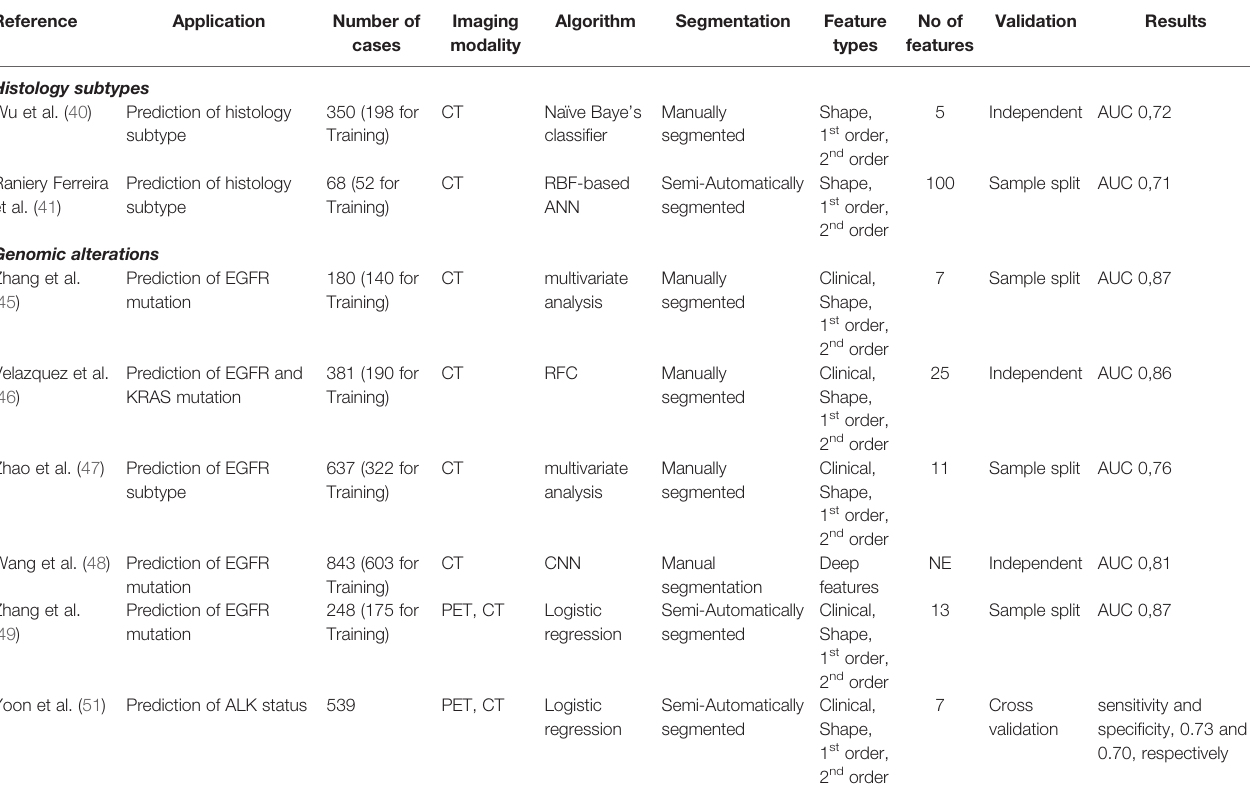
TABLE 2 | Mains studies regarding histology and radio-genomic